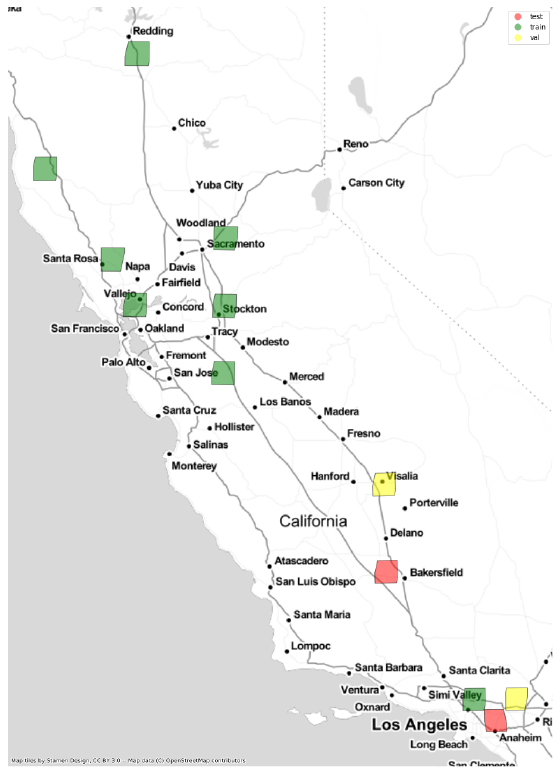
Figure 5. Location of the images considered for the